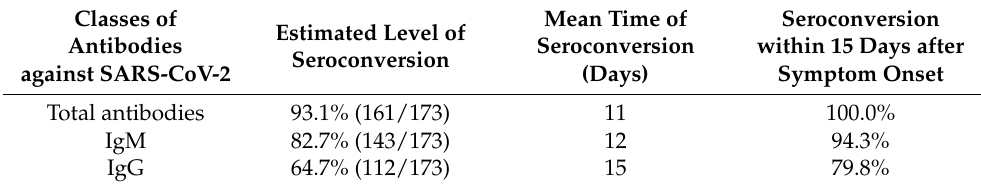
Table 1. Mean time and seroconversion rate in the case of COVID-19 as inferred from the results of examination of 173 patients with confirmed diagnosis by